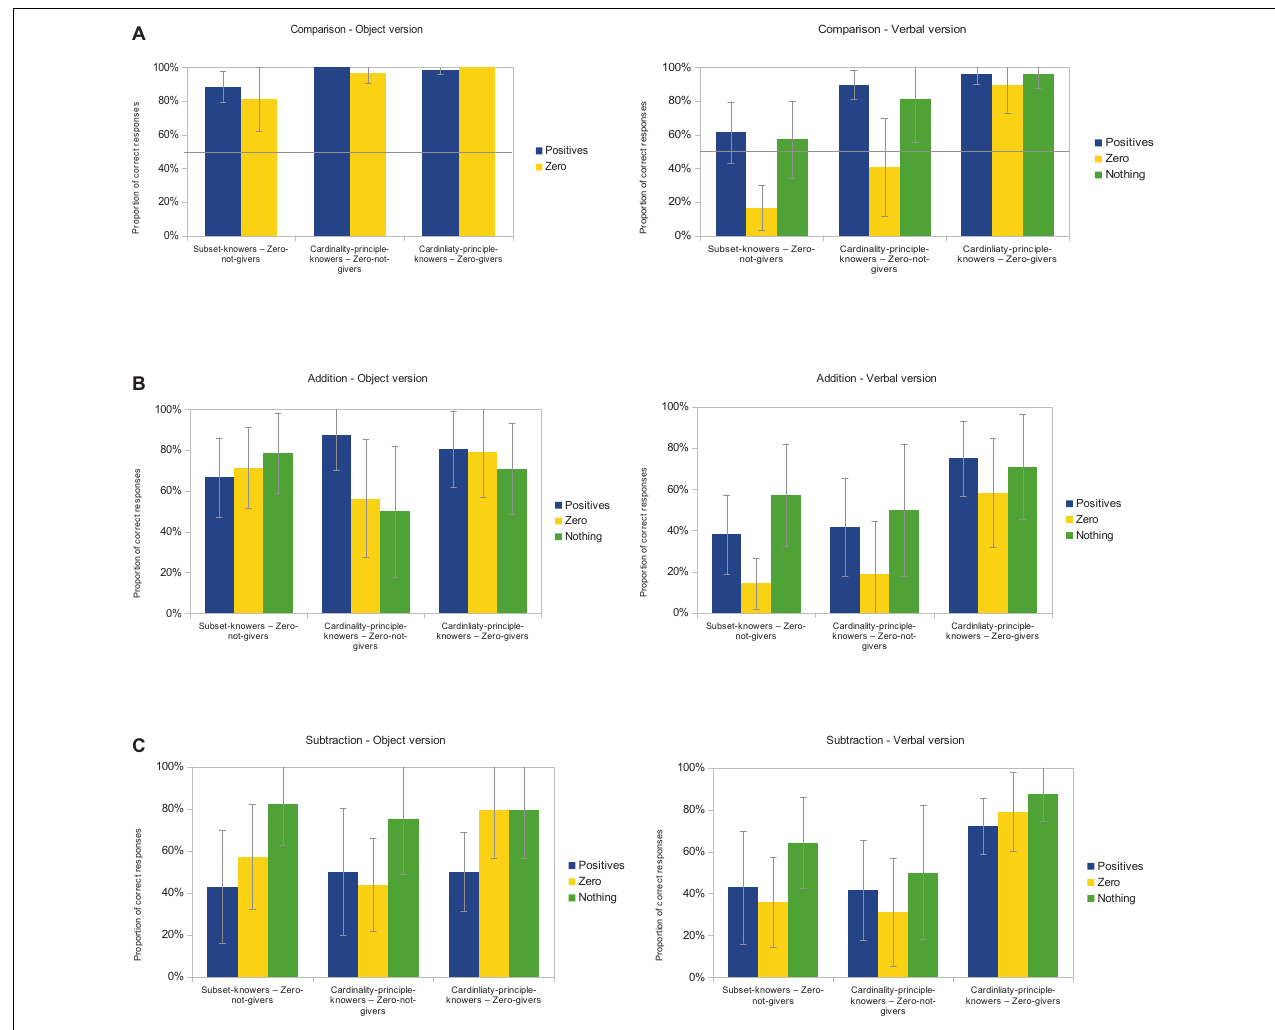
FIGURE 2 | Proportion of correct responses in the comparison (A) , addition (B) , and subtraction (C) tasks in the non-verbal (left) and verbal (right) versions with positive integers, zero, and nothing (columns) within the different number-knowledge groups (categories on x axes). Error bars show 95% confidence interval. Horizontal line at 50% in the comparison task shows the random choice